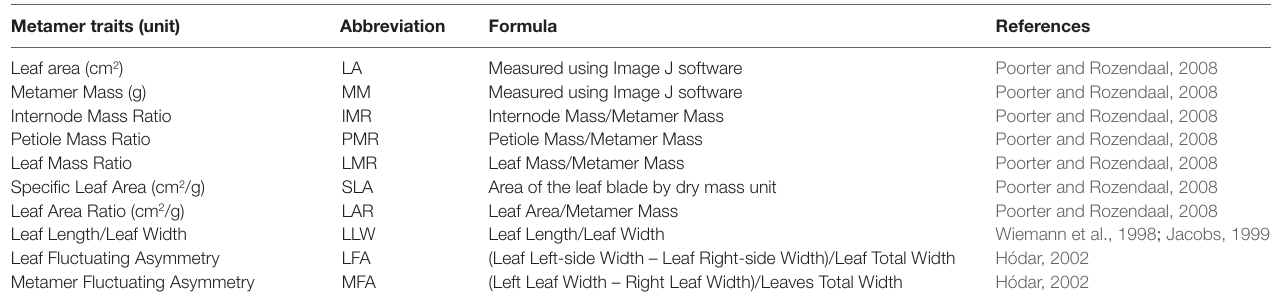
TABLE 2 | Metamer traits of Qualea grandiflora used in the study and their respective abbreviations, formulas and references. Metamer traits